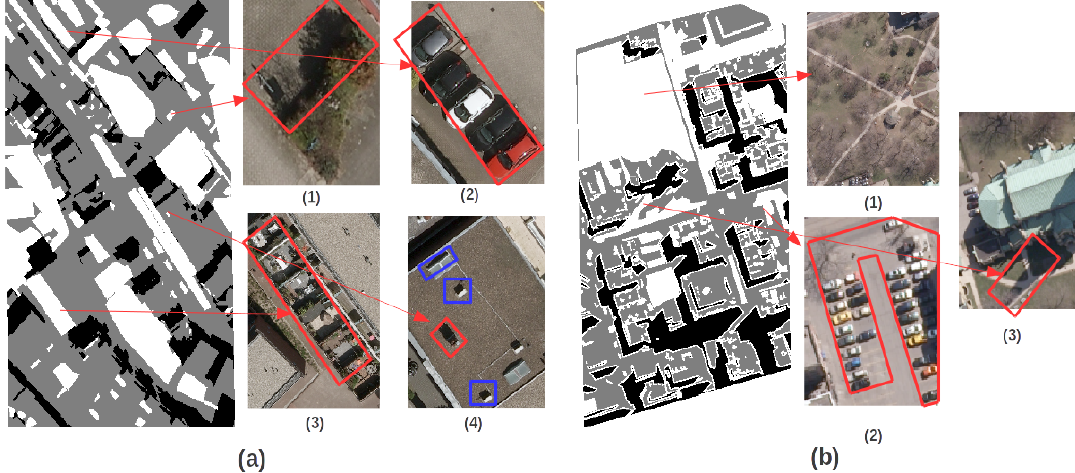
Figure 5. Reference images for Amersfoort ( a ) and Toronto ( b ) in the areas indicated in Figure 2b. The black, gray, and white pixels indicate shadow, non-shadow and excluded pixels. In ( a ), image (1), (2) and (3) show shadow from vegetation, cars and objects in the gardens which are excluded from the reference images, while image (4) shows that if shadows from details on roofs, in the red box, larger than 1m *1m are excluded, and the smaller details in the blue boxes are included in non-shadows. In ( b ), image (1) and (2) show vegetation and cars are excluded in the reference images, while image (3) shows wrongly labeled areas indicated by reconstructed shadows due to model errors are